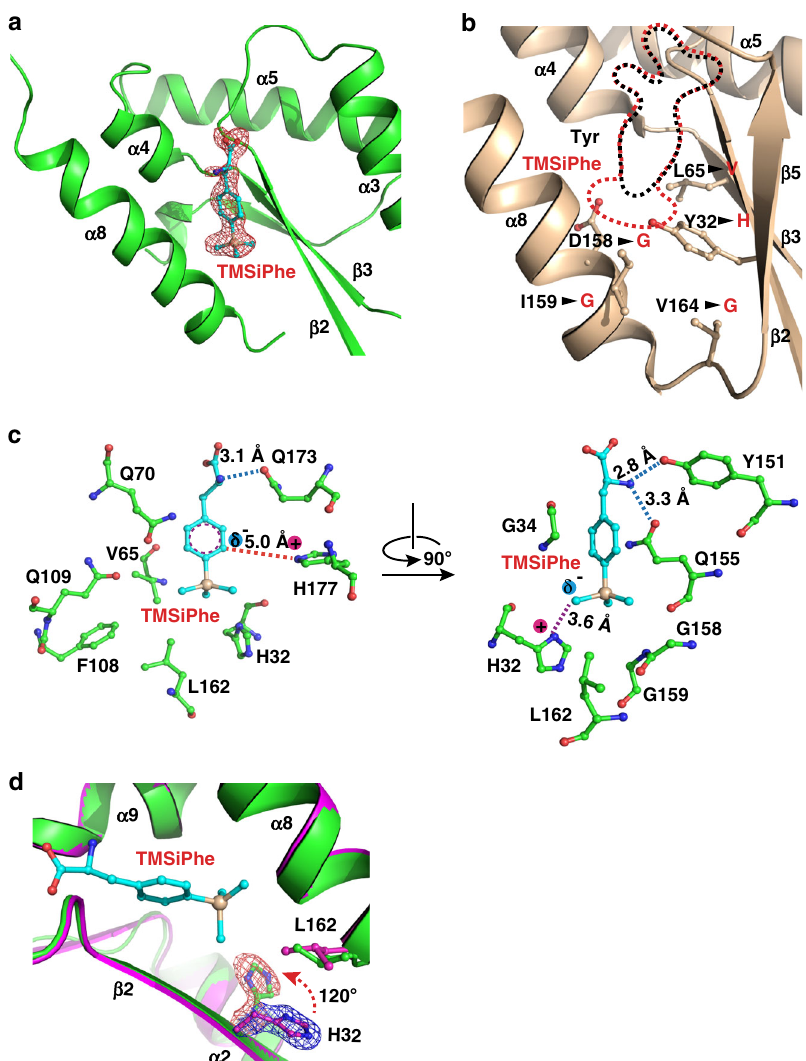
Fig. 2 Structural basis for the selective recognition of TMSiPhe by TMSiPheRS. a Binding of TMSiPhe at the active site of TMSiPheRS. The 2Fo-Fc annealing omit electron density map of TMSiPhe was contoured at 1.0 σ . b Comparison of the unnatural amino acid-binding pockets between TMSiPheRS (red dotted line) and the wild-type Mj -TyrRS (black dotted line, PDB:1J1U). Five key mutations, indicated by arrows, increased the size of the TMSiPhe- binding pocket substantially. c Interactions between TMSiPhe and TMSiPheRS. The speci fi c interactions include hydrogen bonds (blue dotted line), π - cation interactions (red dotted line), ion-dipole interactions (magenta dotted line) and hydrophobic interactions with surrounding residues (left panel). d The H32 residue in the β 2 strand was rotated ~120 degrees in the TMSiPhe/TMSiPheRS complex (green) compared with TMSiPheRS alone (magenta), leading to favorable charged interactions with TMSiPhe. The 2Fo-Fc annealing omit map clearly shows the electron density of H32. The map was contoured at 1.0 σ